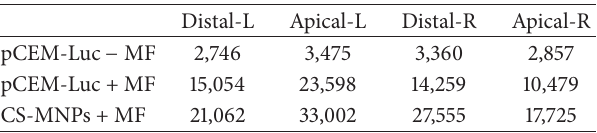
Table 1: Data averages of the RLU expressed in the four sections of the